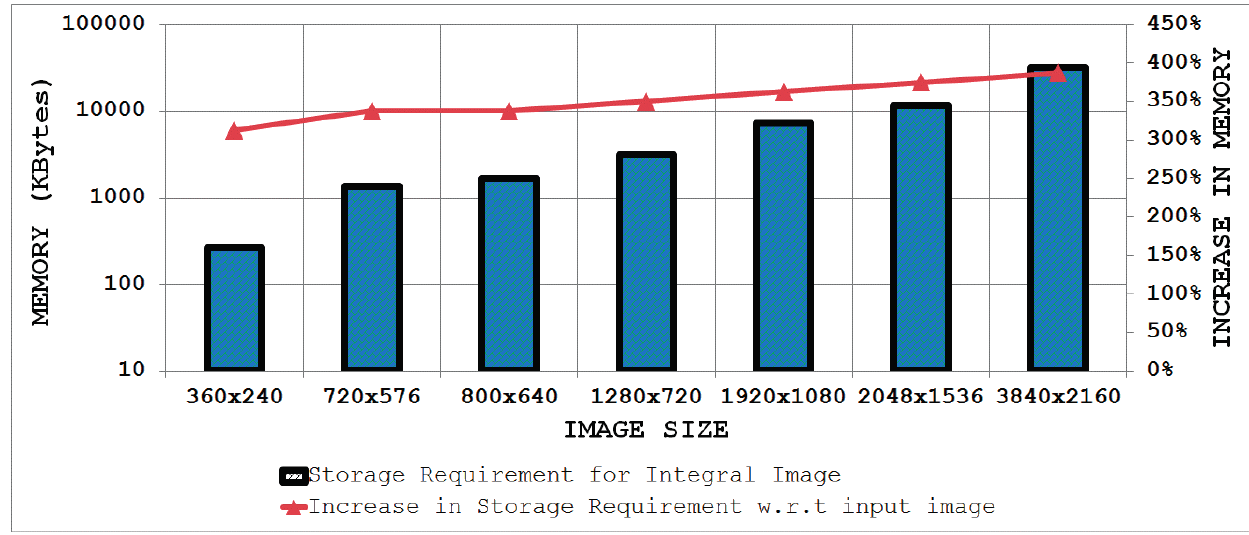
Figure 10. Storage requirements of the integral image for some common image sizes and percentage increase in memory relative to the input image (considering 8-bit